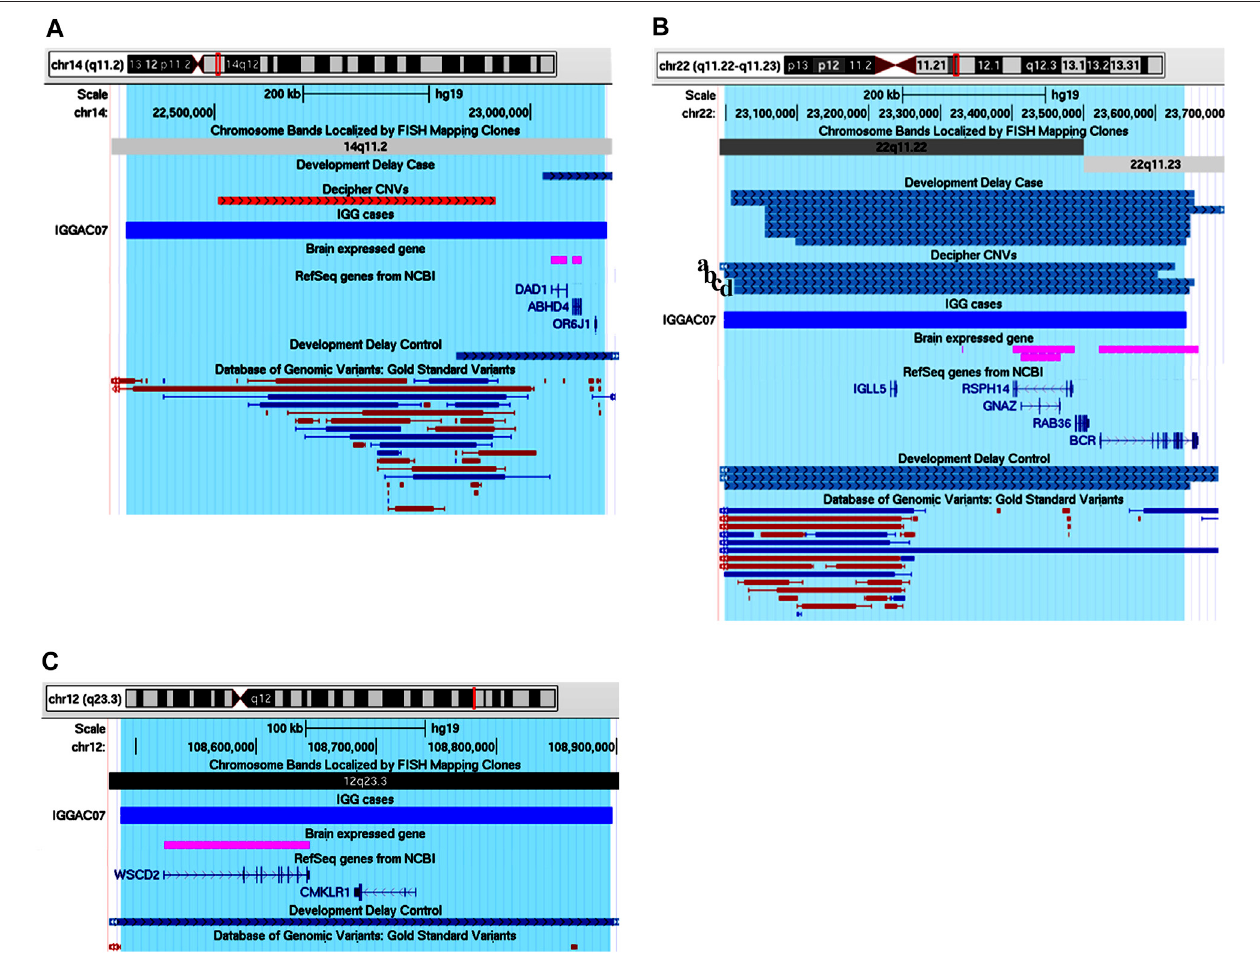
FIGURE7| Additiveeffectsof ABHD4 , GNAZ and WSCD2 inpatientIGGAC07. (A) Screenshotofchromosome14regionencompassingtheduplicationofpatient IGGAC07 (blue bar, chr14:22,360,671-23,120,435). Brain-expressed genes (see Methods ). (B) Screenshot of chromosome 22 overlapping the duplication of patient IGGAC07 (blue bar, chr22:22,998,284-23,643,223). Duplications in Decipher database (a: patient 251352; b: patient 286708; c: patient 301091; d: patient 288064). Brain-expressed genes (see Methods ). (C) Screenshot of chromosome 12 overlapping the duplication of patient IGGAC07 (blue bar, chr12:108,487,109- 108,896,252). Brain-expressed genes (see Methods